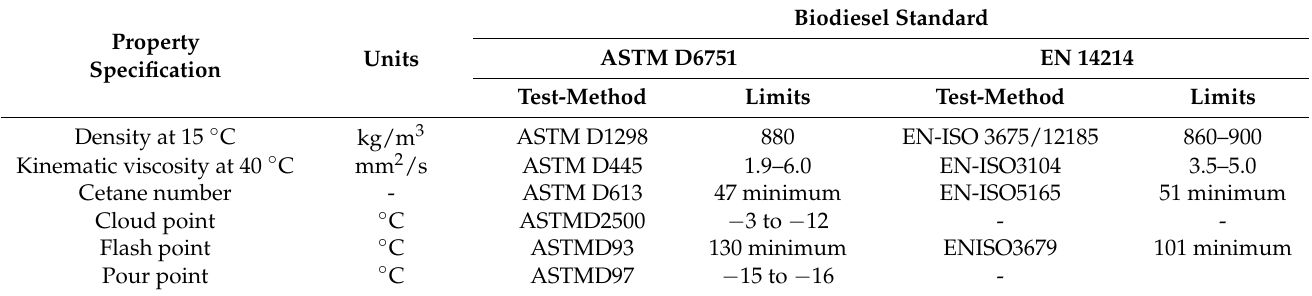
Table 2. ASTM D6751 and EN 14214 standards for biodiesel fuel